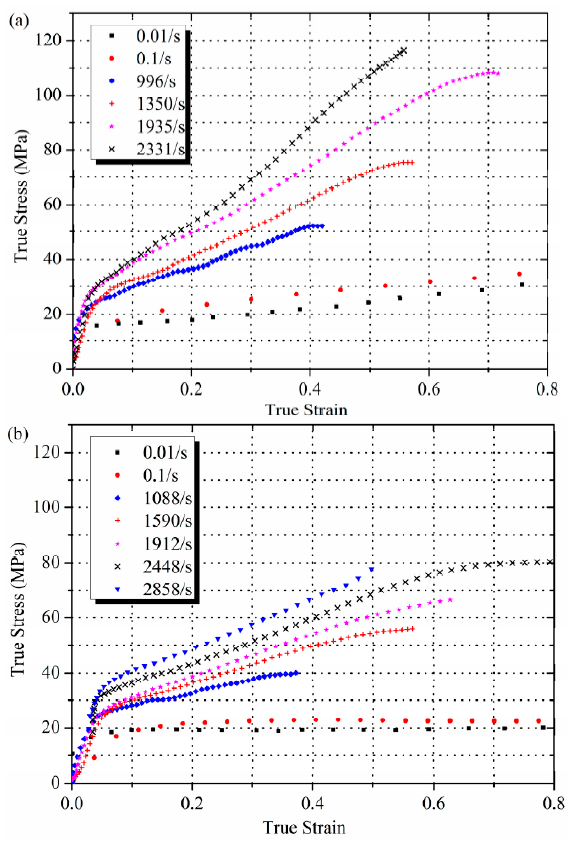
Figure 4. Stress-strain curves of ( a ) low crystalline and ( b ) high crystalline Al-PTFE tested in compression at room temperature.